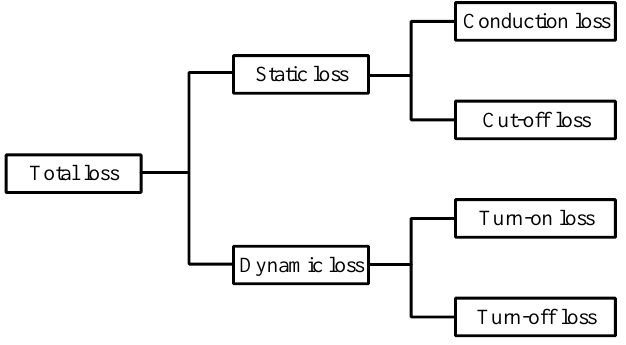
Figure 2. The components of SiC MOSFET’s loss.